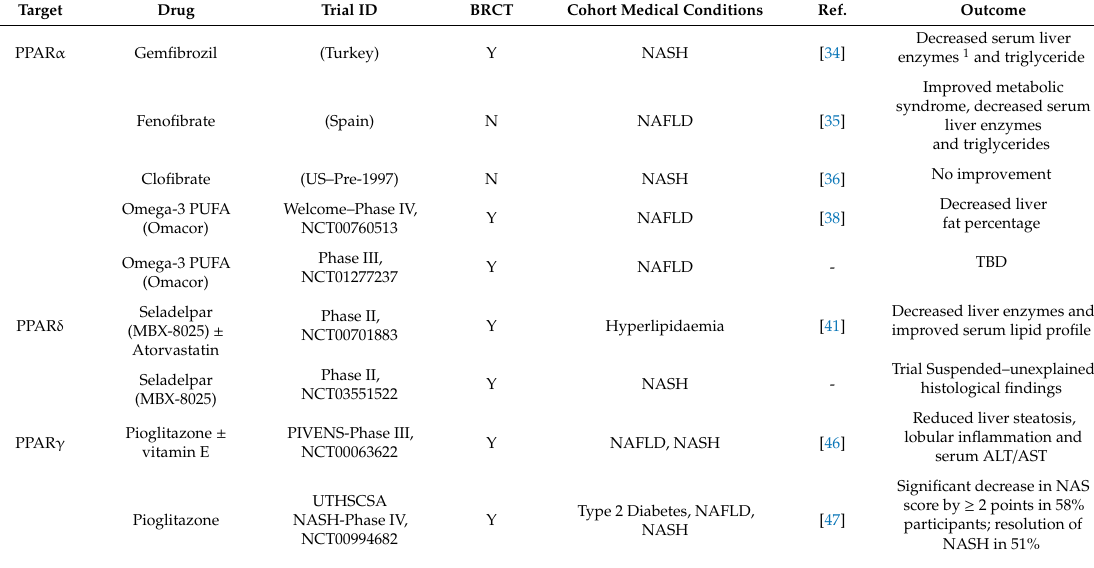
Table 1. Overview of current and pipeline treatments for NAFLD and